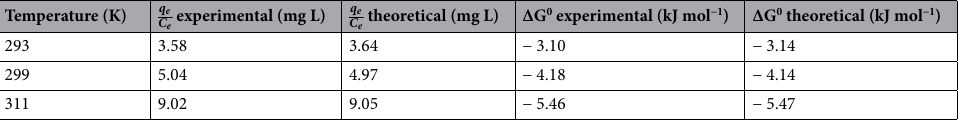
Table 4. Thermodynamics evaluation of the adsorption process. Equilibrium constant and free energy obtained from experimental and theoretical data. Experimental data obtained for DCF solution of 100 mg −1 L, 10 mg of adsorbent material, pH 1, stirring speed = 650 rpm and contact time = 10 min.